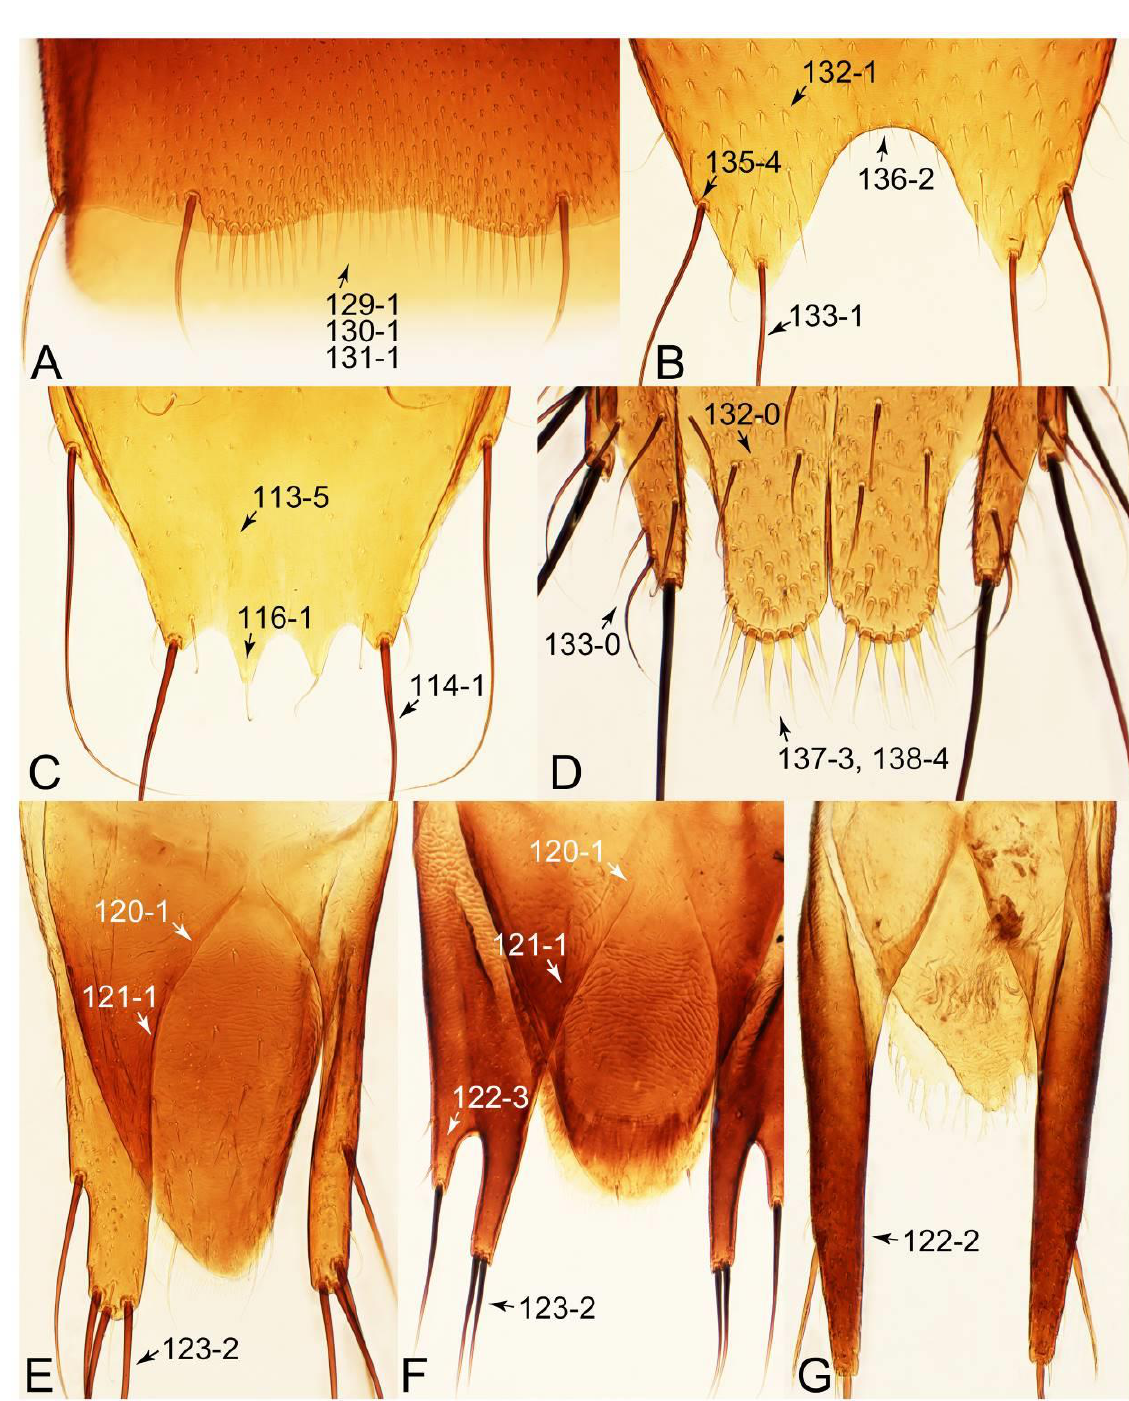
Figure 55. Photographs of body parts of Tachinusini, enlarged. ( A ) male sternite VII of Tachinomorphus grossulus , ventral view. ( B ) male sternite VIII of Leucotachinus luteonitens , ventral view. ( C ) male tergite VIII of Leucotachinus luteonitens , dorsal view. ( D ) female sternite VIII of Nitidotachinus tachyporoides , ventral view. ( E ) male tergite IX of Leucotachinus luteonitens , dorsolateral view. ( F ) male tergite IX of Olophrinus cf. philippinus , dorsolateral view. ( G ) male tergite IX of Tachinomorphus grossulus , dorsal view. Characters and character states (format X-X) are indicated on each